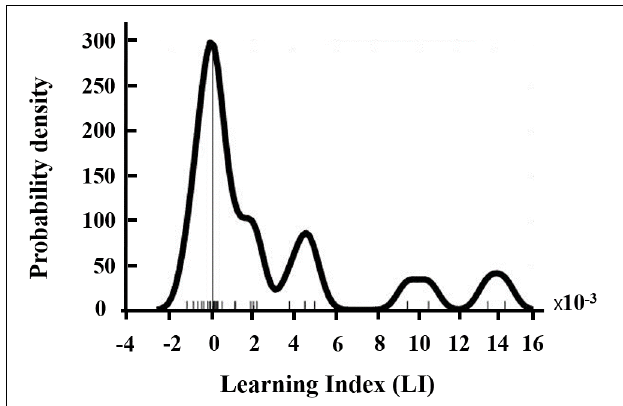
FIGURE 1 | Distribution of NFB learning index